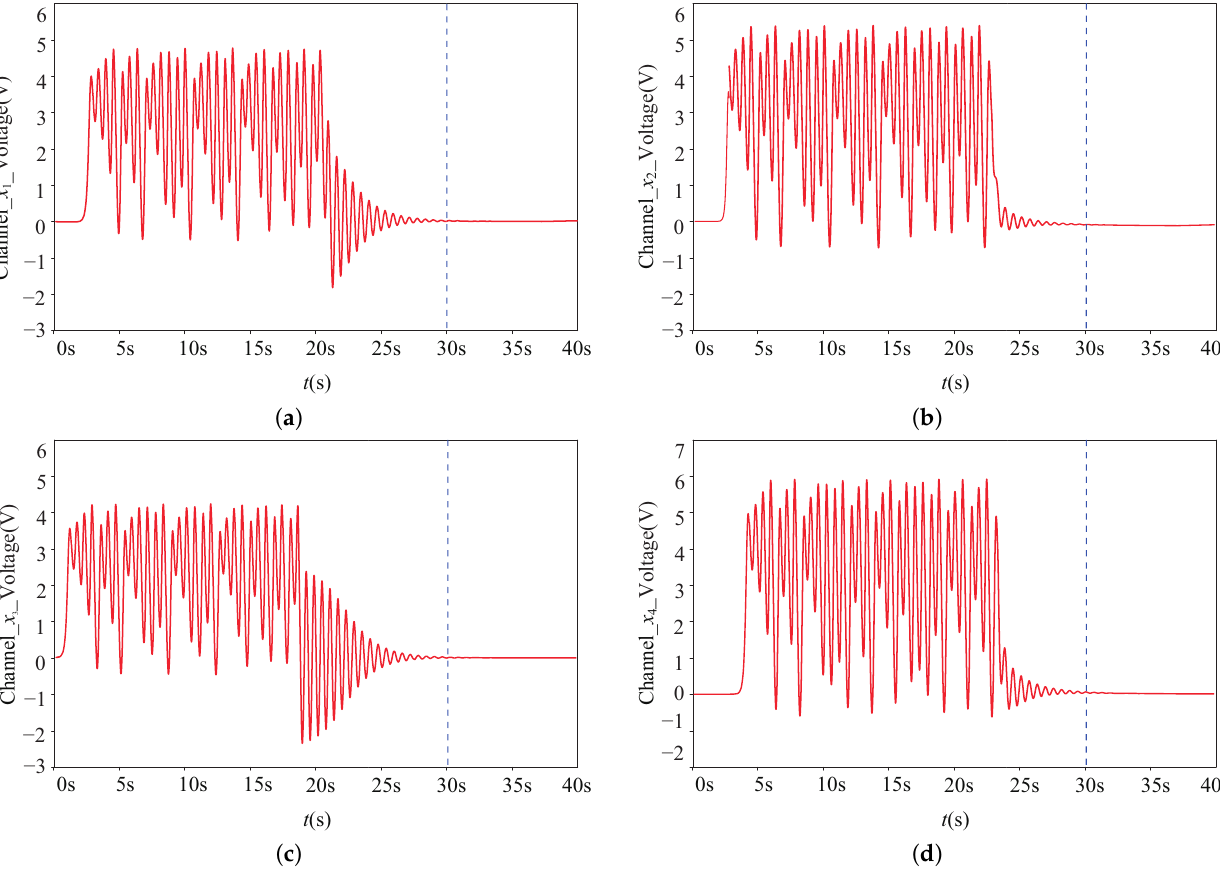
x 1 plane; ( b ) t x 2 − −